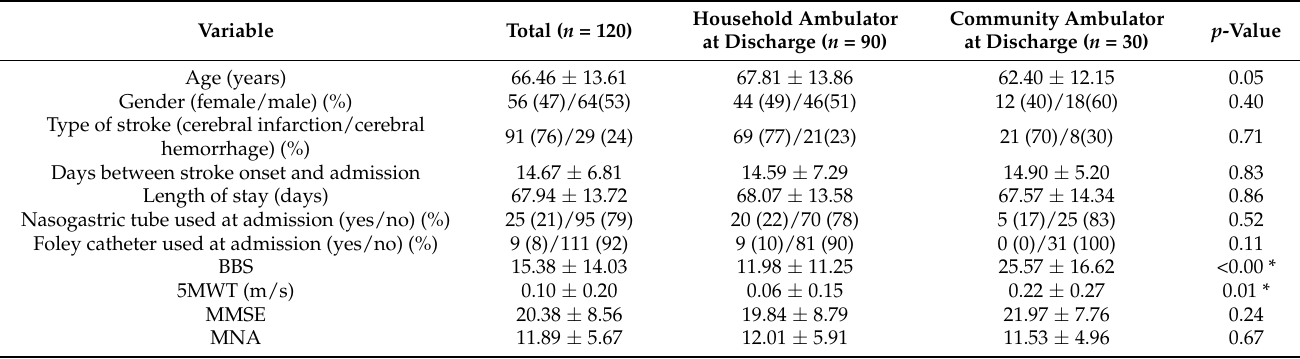
Table 1. Participant characteristics at admission.